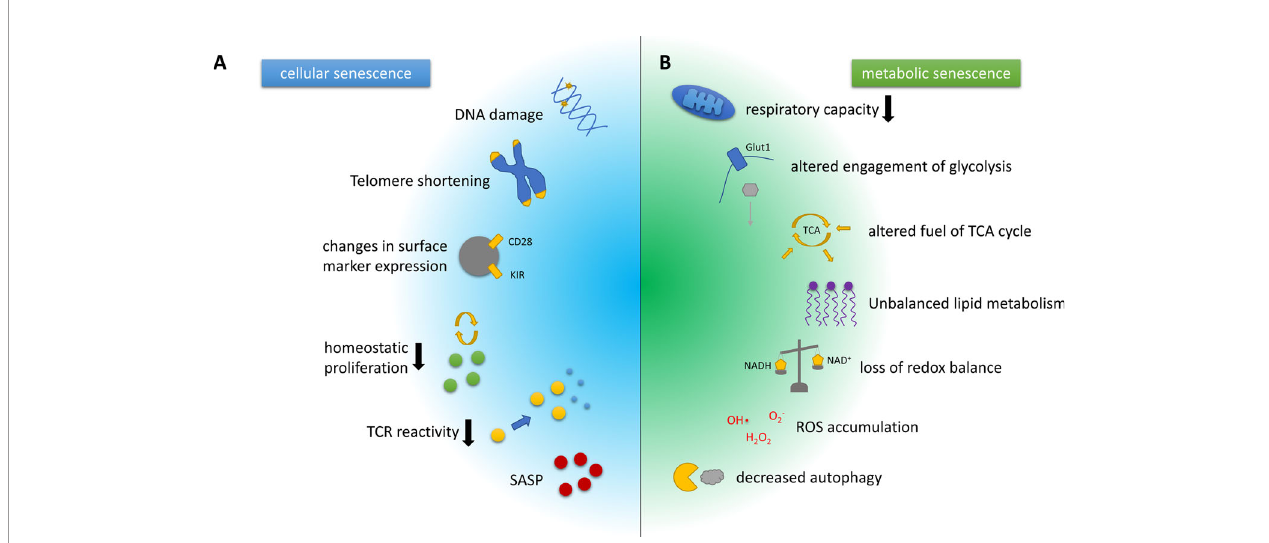
FIGURE 1 | Hallmarks of cellular and metabolic senescence and/or aging in T cells. (A) Key characteristics of cellular senescence include DNA damage and telomere erosion that contribute to genomic instability and dysregulation of the epigenome. Phenotypically, T cell senescence is associated with a loss of surface CD28 expression and the upregulation of innate T cell markers such as the killer cell immunoglobulin-like receptors (KIRs). The involution of the thymus increases the homeostatic pressure on T cells. Senescent T cells, however, show a diminished capacity for homeostatic proliferation, and additionally feature reduced T cell receptor (TCR) reactivity. Another hallmark of T cell senescence is the production of pro-in fl ammatory mediators, collectively known as senescence-associated secretory phenotype (SASP). (B) Key metabolic characteristics associated with T cell senescence and aging often closely interwoven and include a decline in the respiratory capacity or ef fi cacy and substantially altered engagement of glycolysis, as well as alterations in the pathways used to fuel the tricarboxylic acid (TCA) cycle, which are likely context- and cell subset-dependent. The same holds true for the dysbalanced lipid metabolism observed in senescent/aged T cells. In addition, ratios of coenzymes for metabolic reactions such as NAD/NADH that are crucial for balancing the cellular redox state are shifted in senescent cells. Furthermore, reactive oxygen species (ROS) accumulate and eventually cause DNA and protein damage. Damaged organelles, cell membranes and proteins are usually degraded by autophagy, another pivotal mechanism that is attenuated by the aging or the senescent